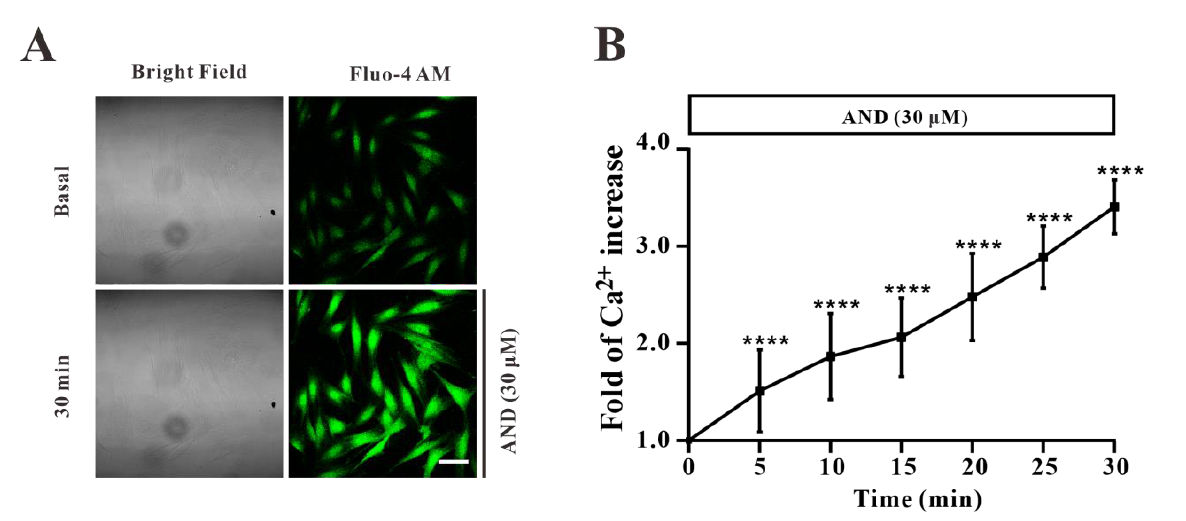
Figure 8. AND induced increased Ca 2+ concentration in L6 cells. ( A ) Images of Ca 2+ concentration changes in L6 ce lls treated with AND. Scale bar: 50 μm. ( B ) The change of intracellular Ca 2+ fluorescence intensity caused by AND within 30 min, n = 15 cells. ****: p < 0.0001.